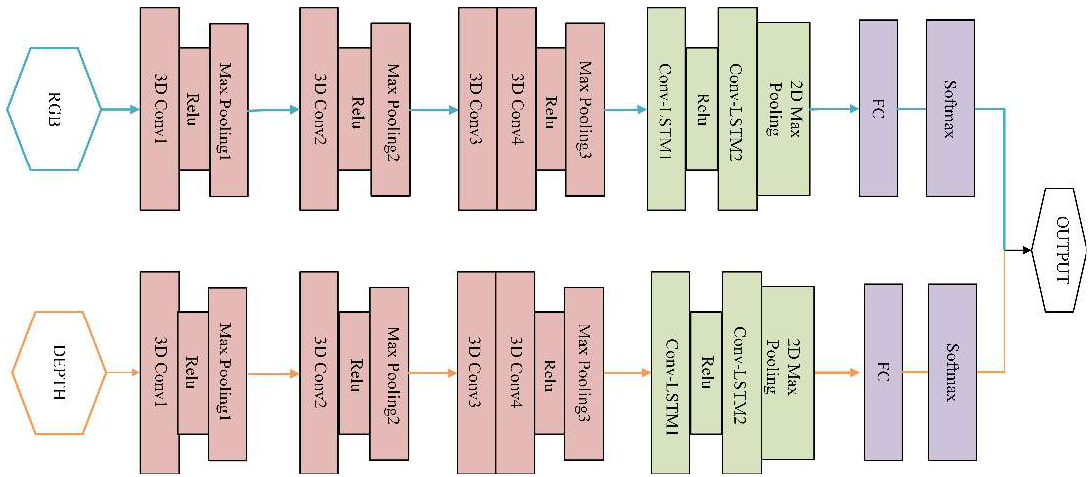
Figure 5. An architecture of muti-modal fusion model.